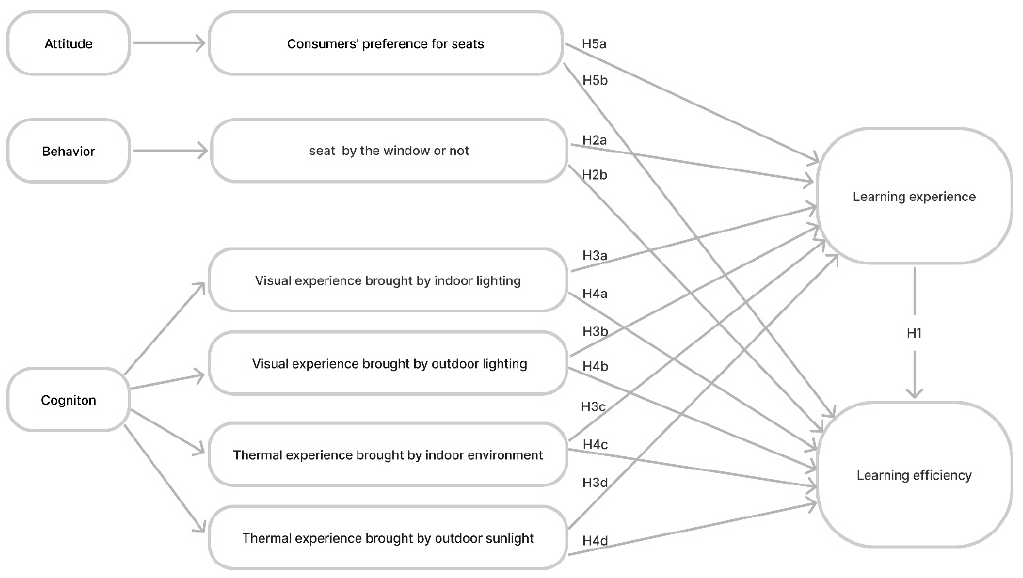
Figure 3. The conceptual model of the consumption behavior of library window seats.